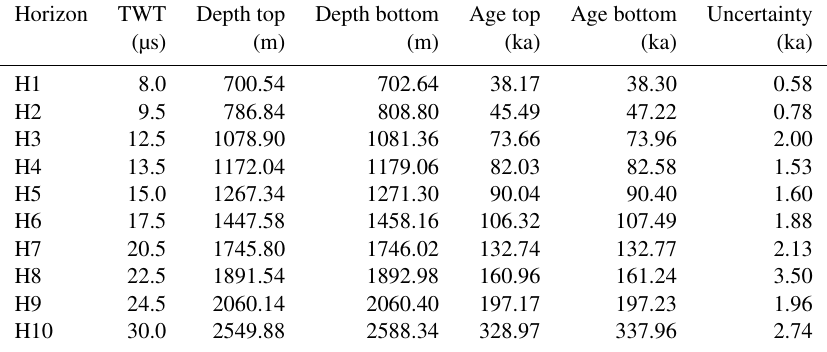
Table 2. Identified layers of Figs. 2 and 3, their approximate TWTs, depth ranges of their inducing conductivity sections and corresponding age with age uncertainties (average of published AICC2012 age uncertainties of the top and bottom depth) on the AICC2012 timescale (Veres et al., 2013; Bazin et al.,